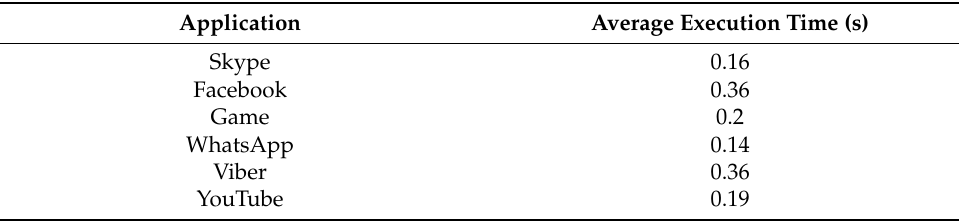
Table 4. Average execution time for each instance of optimization for the different